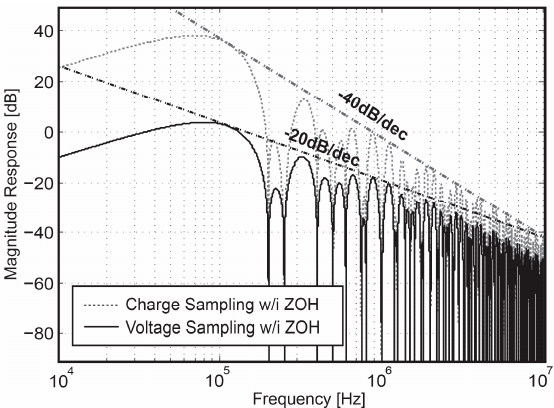
Figure 4. Transfer function of the charge-domain CDS vs. voltage-domain CDS.